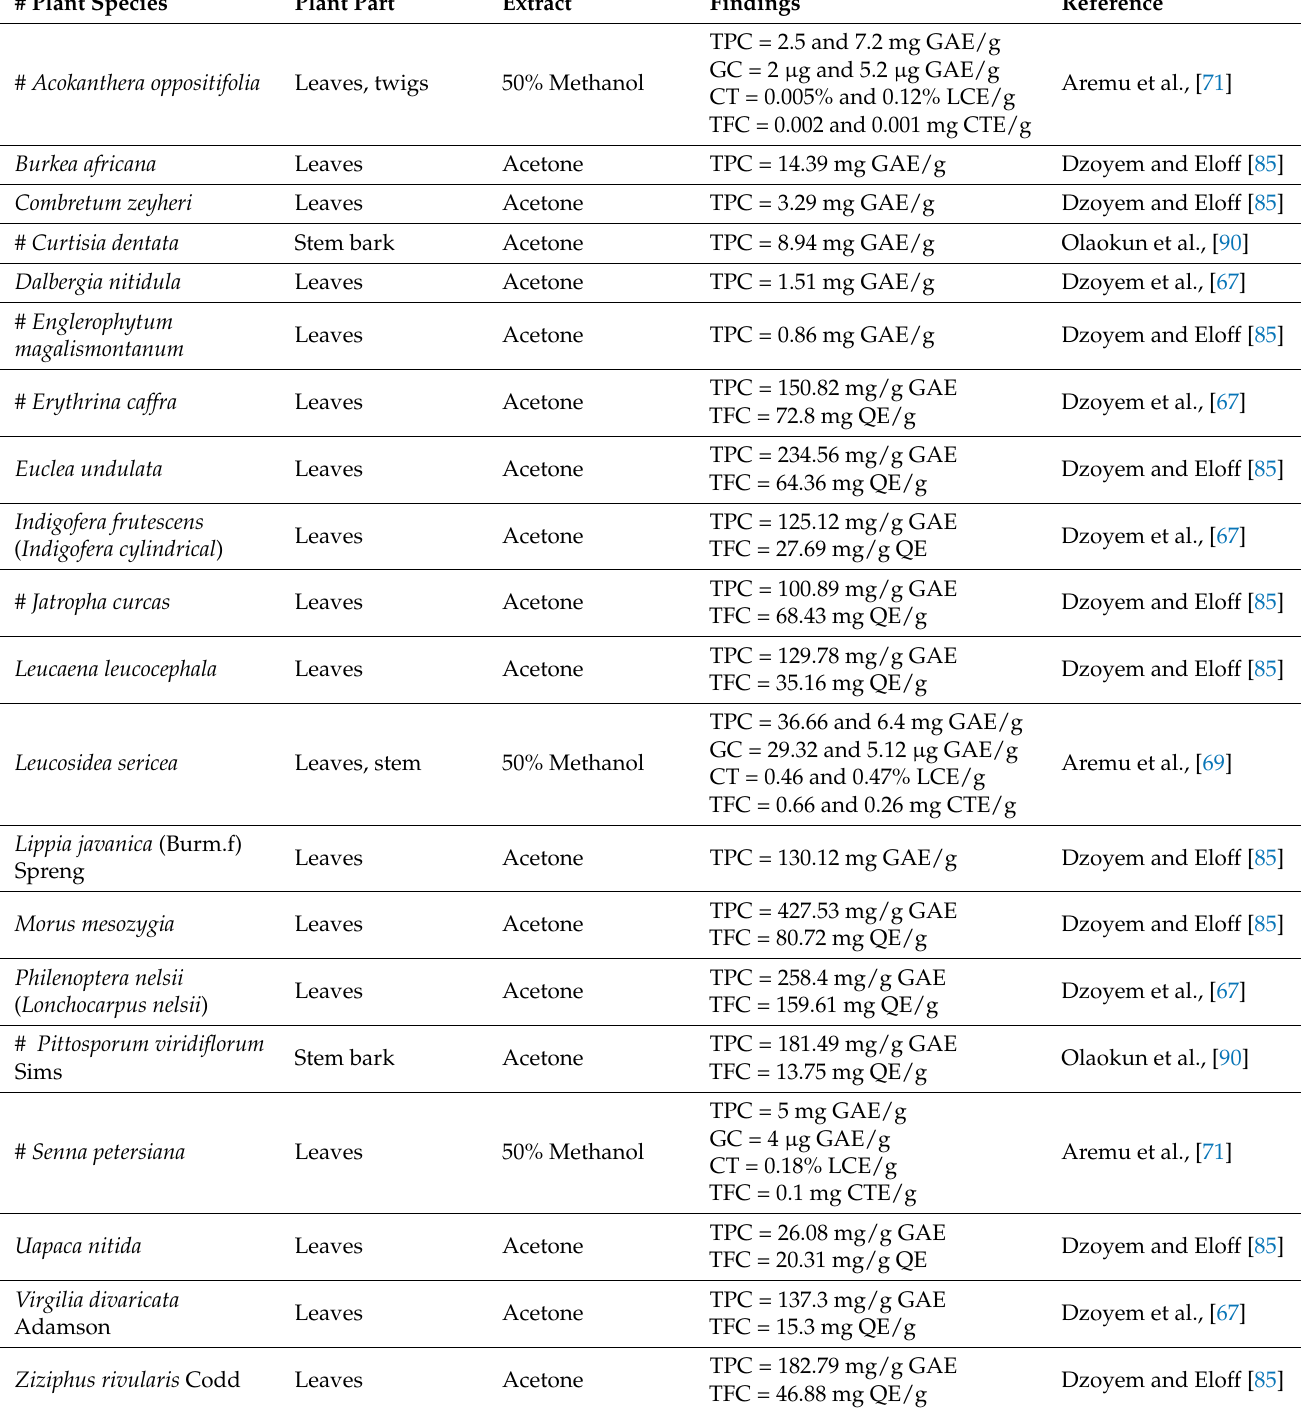
Table 7. Phytochemical analysis (based on spectrophotometric method) of woody plants used in ethnoveterinary medicine. # Plant species: denotes woody plants with ethnoveterinary uses in Table 2; GAE—gallic acid equivalents,